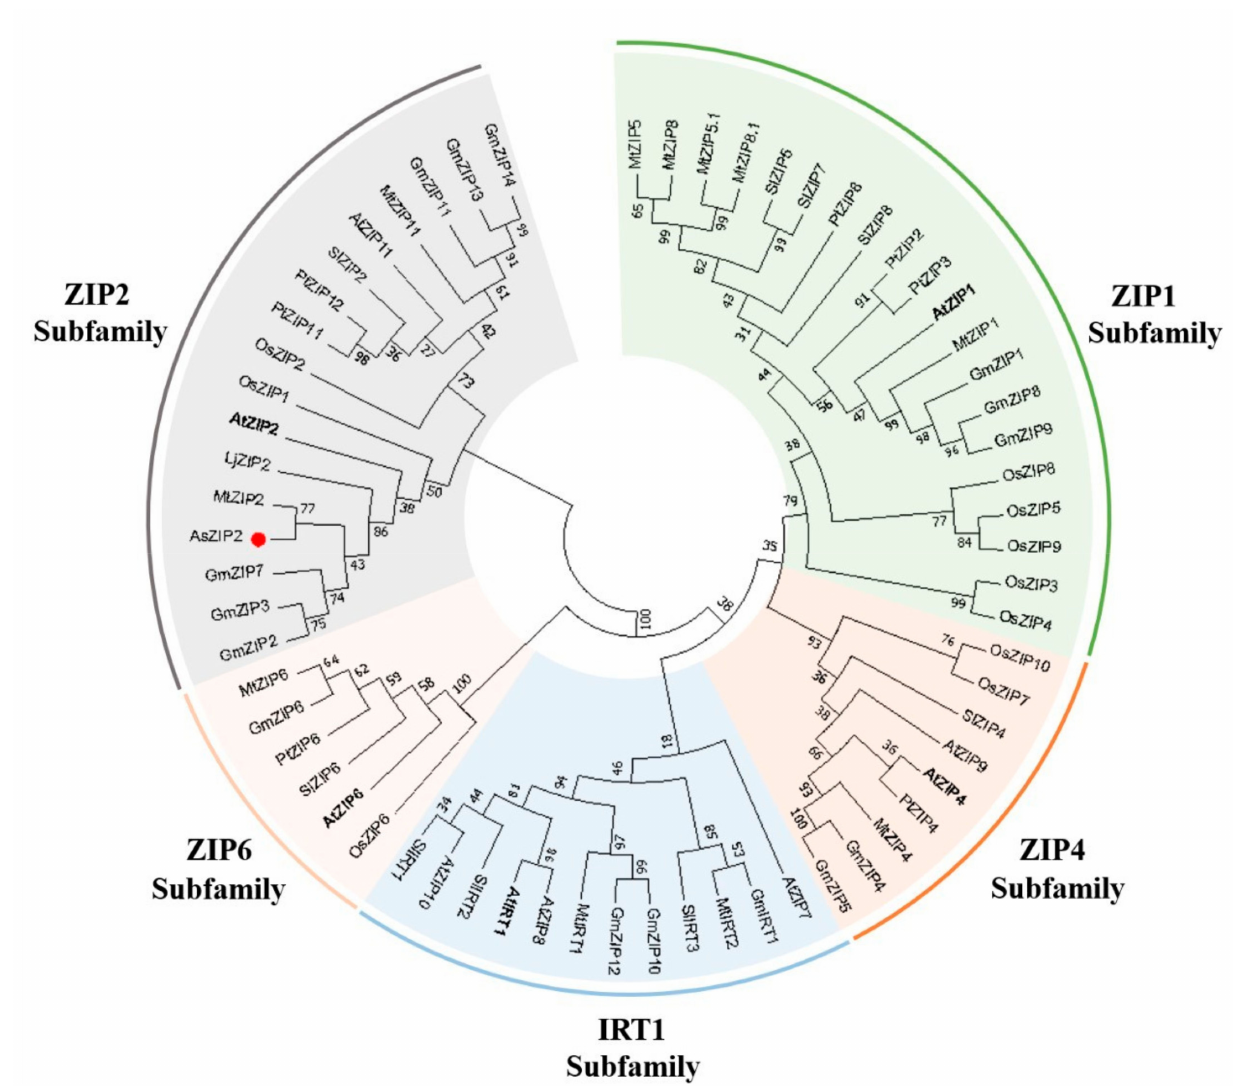
Figure 2. Evolutionary relationship among AsZIP2 in A. sinicus and ZIP family zinc/iron transporters in different plant species. The evolutionary history was inferred using MEGA7.0 program with the Neighbour–Joining method (Kumar et al., 2016). The evolutionary distances were computed using the Poisson correction method. All ambiguous positions of the 63 amino acid sequences were removed for each sequence pair. Plant ZIP family proteins tested were classified as five subfamilies based on sequence similarity. The branch marked with a red circle represents the Zn transporter AsZIP2 of A. sinicus in this study. The accession numbers and plant species names are provided in Supplementary Table